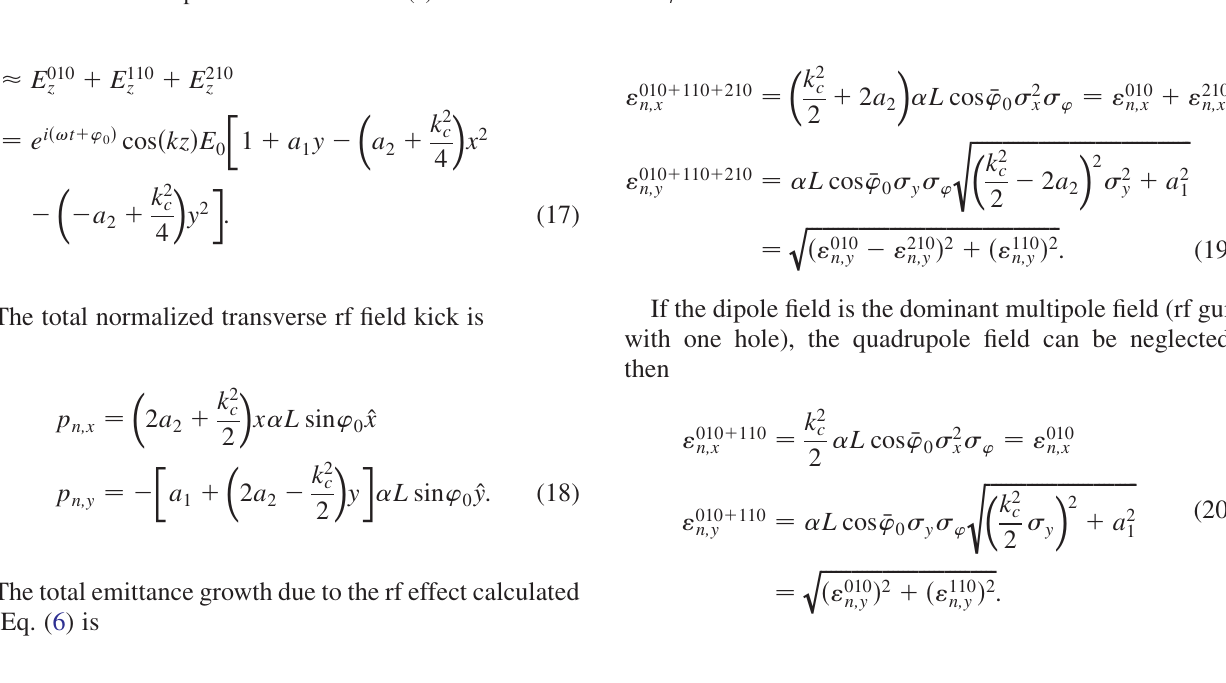
FIG. 3. Field distribution along the (cid:1) direction. (a) The rf field E r distribution along the (cid:1) direction for the models shown in Fig. 1 at z ¼ 61 mm (middle of the full cell), r ¼ 9 : 5 mm . (b) Distribution of the artificial rf field, which is the combination of the monopole and the dominant component of each model. (c) Fourier coefficient of E r of 1.6 cell models with a different number of holes.